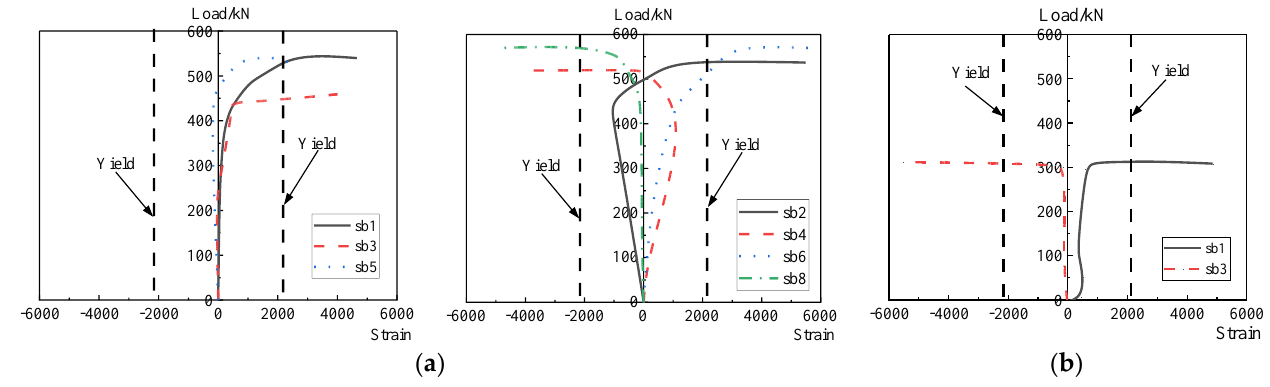
Figure 10. Load–strain curve of perforating rebar: ( a ) P-1; ( b ) P-4.